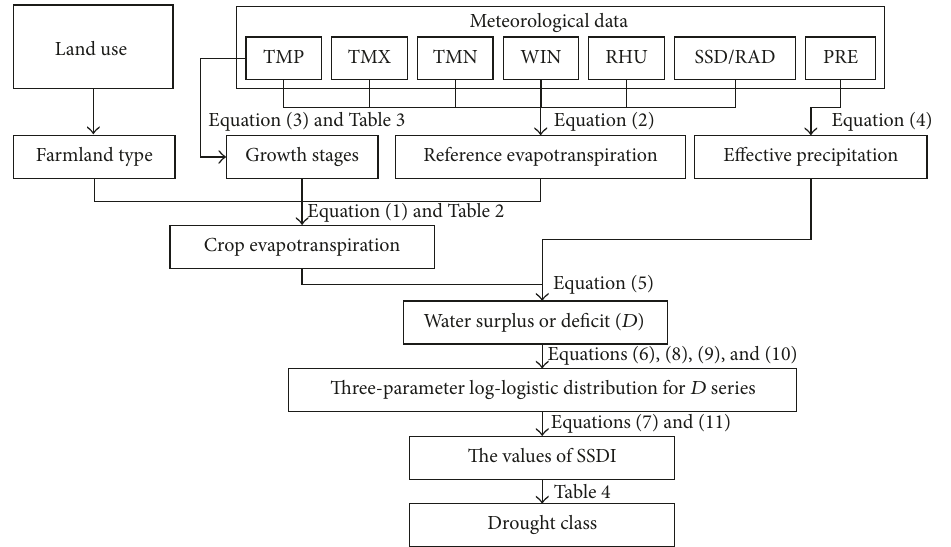
Figure6:Theprocedureofdroughtassessment.TMP,TMX,TMN,WIN,RHU,SSD,RAD,andPREareabbreviationforaveragetemperature, highest temperature, lowest temperature, wind speed, relative humidity, sunshine hours, total solar radiation, and precipitation.